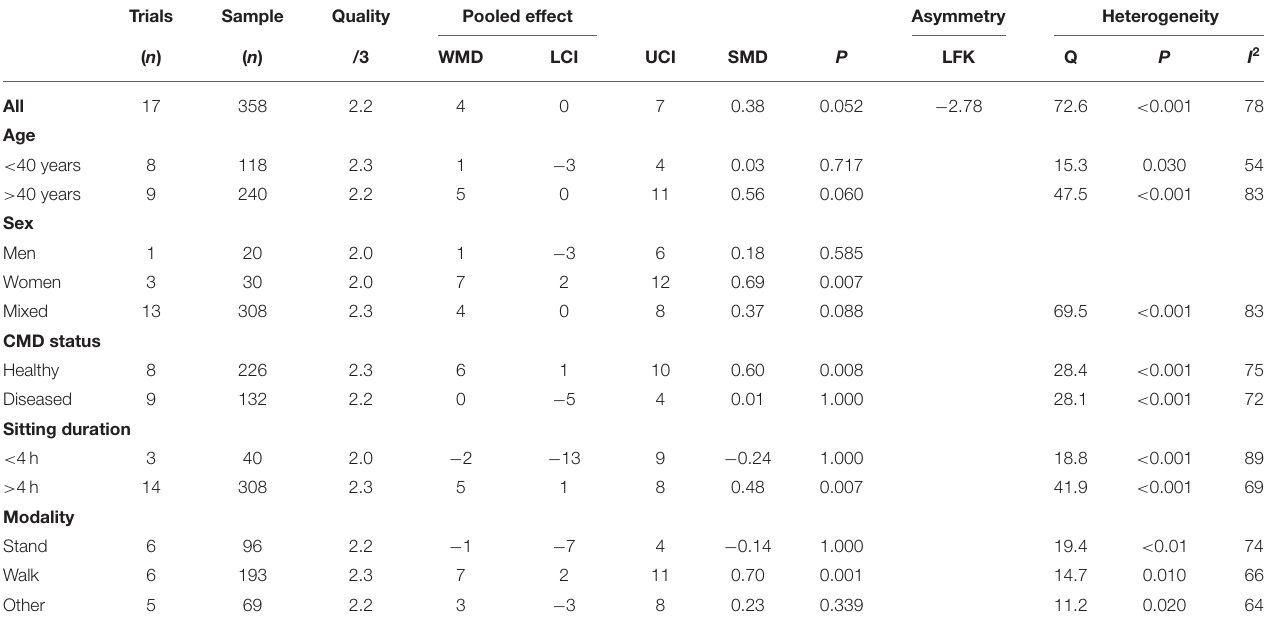
TABLE 3 | The effect of prolonged sitting with interruption on HR.